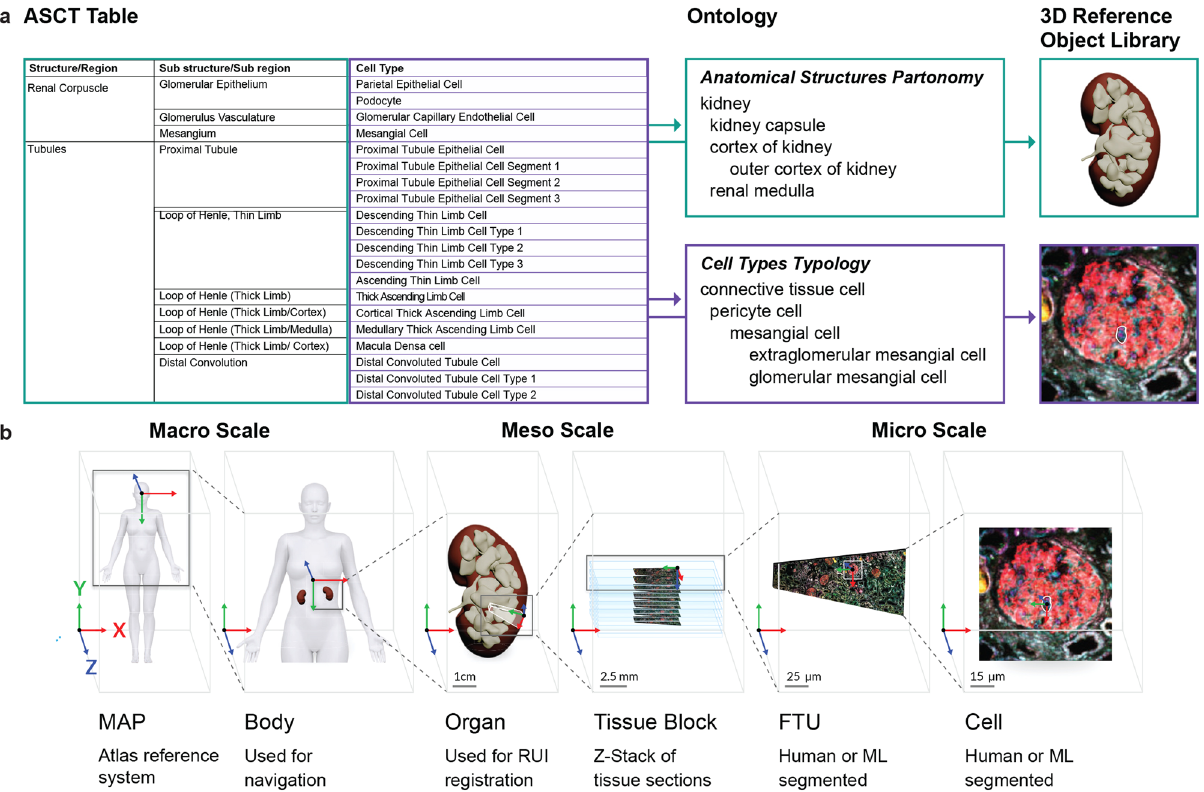
Fig. 4 Semantic and Spatial Representation of a Kidney. a The CCF Biological Structure Ontology represents the body as a set of nested, named anatomical structures (the anatomical structures “ partonomy ” ) and cell types (the cell type “ typology ” ). Anatomical structures and cell types are linked to Uberon/FMA and CL ontologies respectively, and are mapped to 3D reference objects at macro to single-cell level. b The CCF Spatial Ontology leverages the 3D Reference Object Library to de fi ne the dimensions and shapes of ASCT + B entities within the HRA 3D space (called the ‘ Atlas reference system ’ ). The male and female VHP reference bodies are registered within the HRA space. All organ reference objects are registered to the respective male or female VHP reference body. A new tissue block is sized, positioned, and rotated relative to a reference organ. Segmentation masks for single cells and functional tissue units identi fi ed via manual or automatic means are spatially registered with their respective tissue section images – z-stacks of 2D tissue sections make up 3D tissue